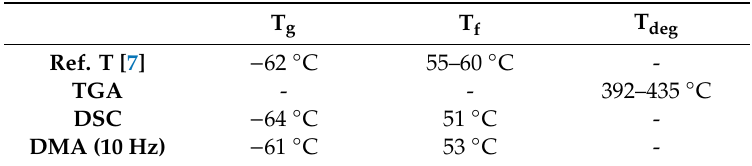
Table 2. Thermal characterization of PCL. T g is the glass transition temperature, t f the melting point, and T deg the degradation temperature.